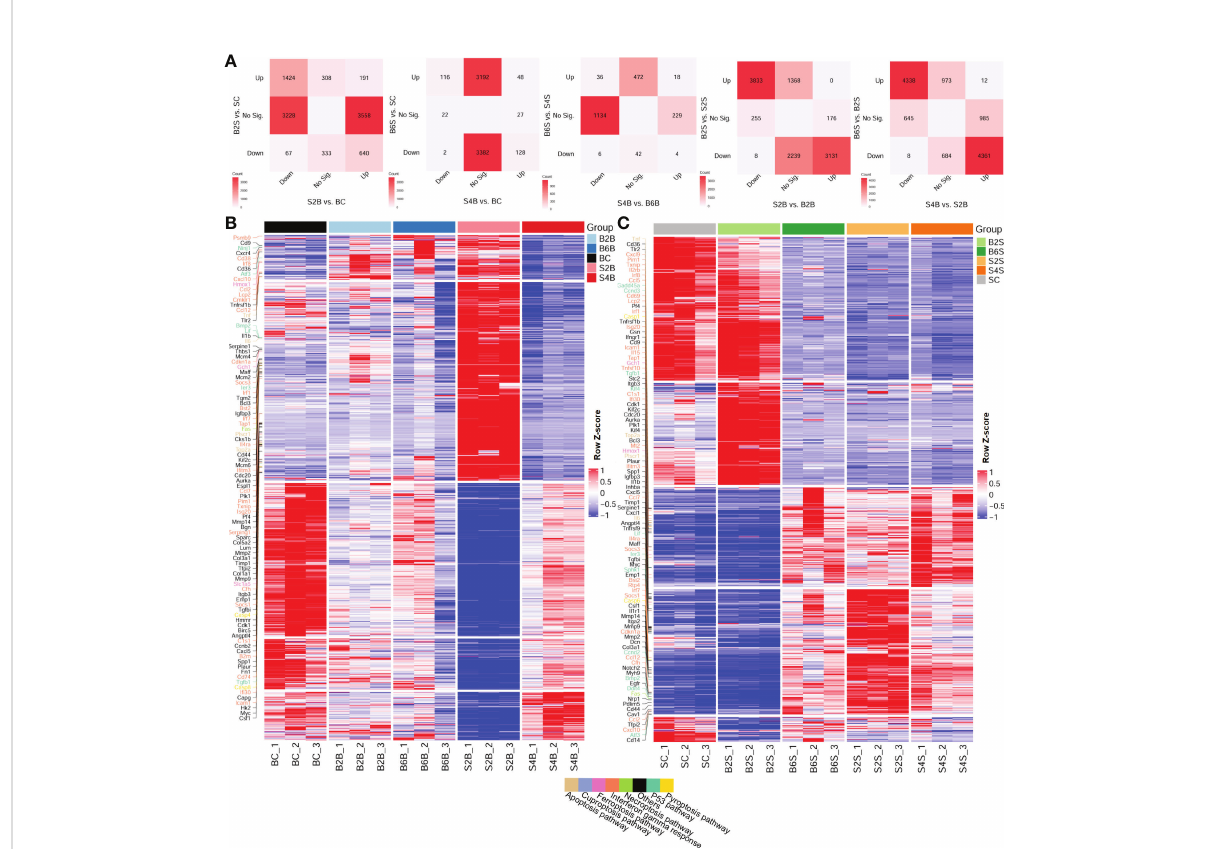
FIGURE 2 Comparative analysis of the up- and downregulation of the differentially expressed genes (DEGs) between the brain and skull with ischemic injury at different time points. (A) Number of intersecting DEGs in the different groups of brain and skull samples (upregulated: FC > 2 and FDR < 0.05; downregulated: FC < 1/2 and FDR < 0.05). FC , fold change; FDR , false discovery rate ; No Sig. , not signi fi cant. (B, C) Heatmap of the brain (B) and the skull (C) after photothrombosis (PT) with DEGs ( different colored genes are the representative genes from the cancer hallmark to the cell death pathways). BC , control group for the uninjured brain; B2B and B6B , brain samples of the second and sixth days after brain PT; SC , control group for the uninjured skull; S2S and S4S , skull samples of the second and fourth days after skull PT; B2S and B6S , skull samples of the second and sixth days after brain PT; S2B and S4B , brain samples of the second and fourth days after skull PT. ( B , C , show the rows clustered using Pearson ’ s